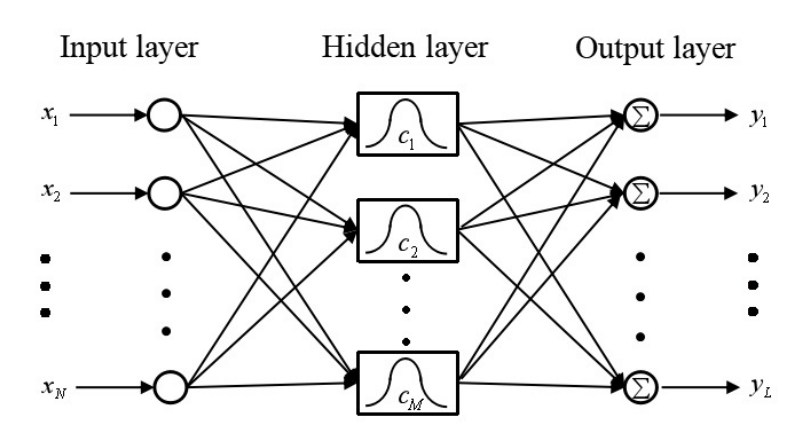
Figure 1. Structure of radial basis function (RBF) neural network in N - M - L